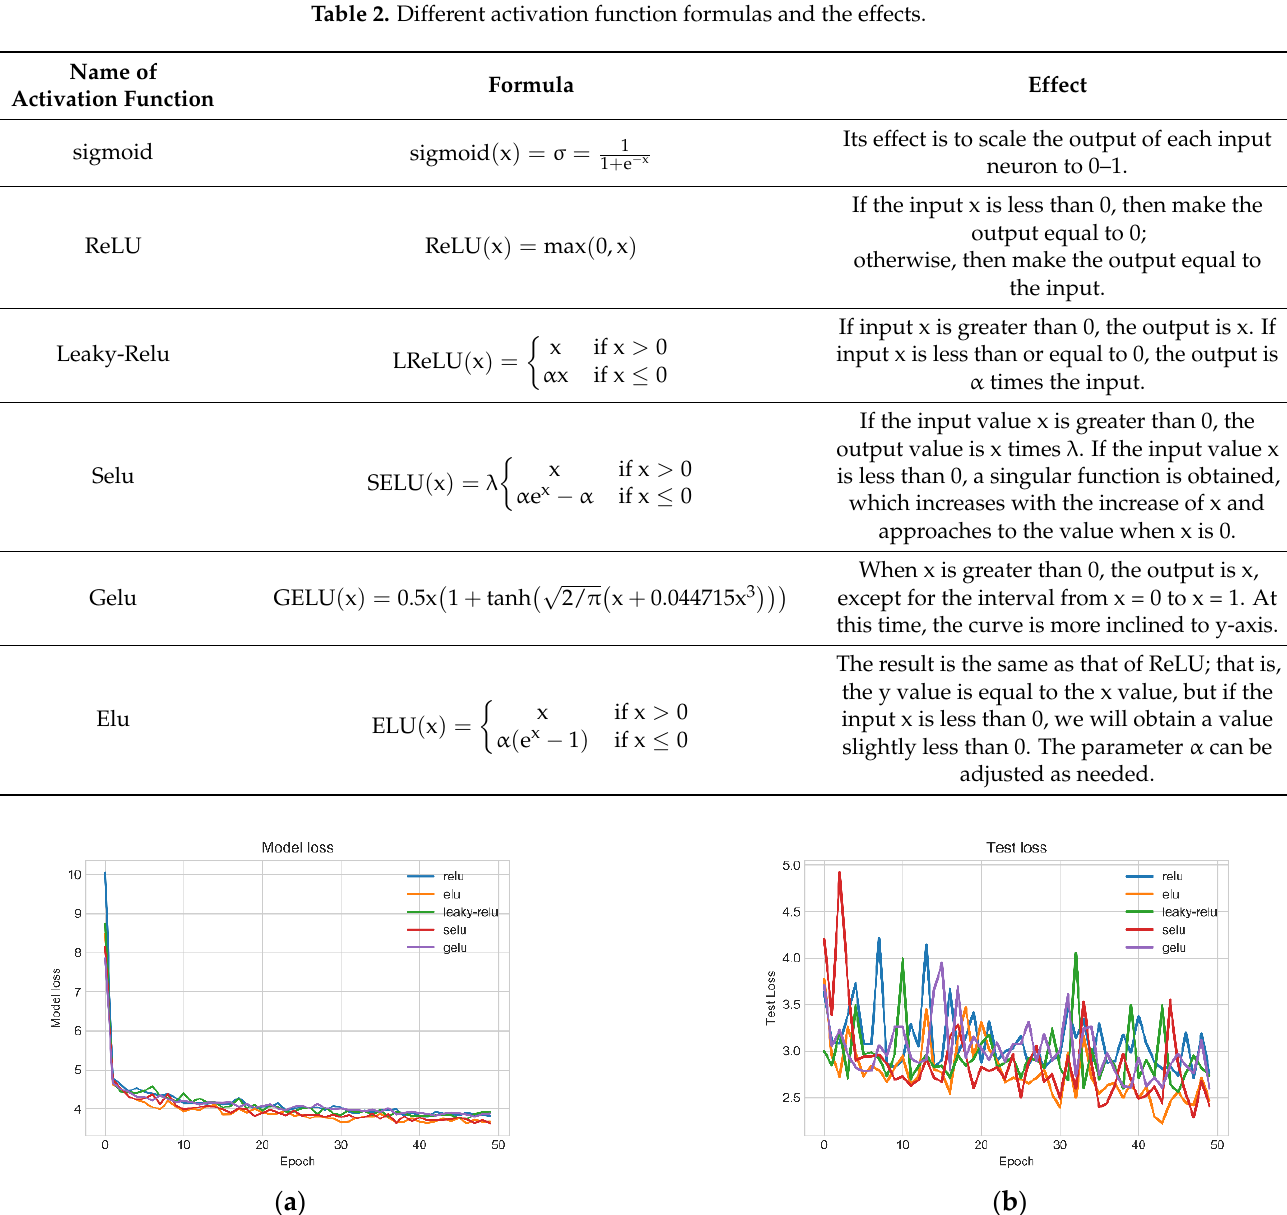
Figure 15. Errors of different activation functions in the training set ( a ) and test set ( b ).